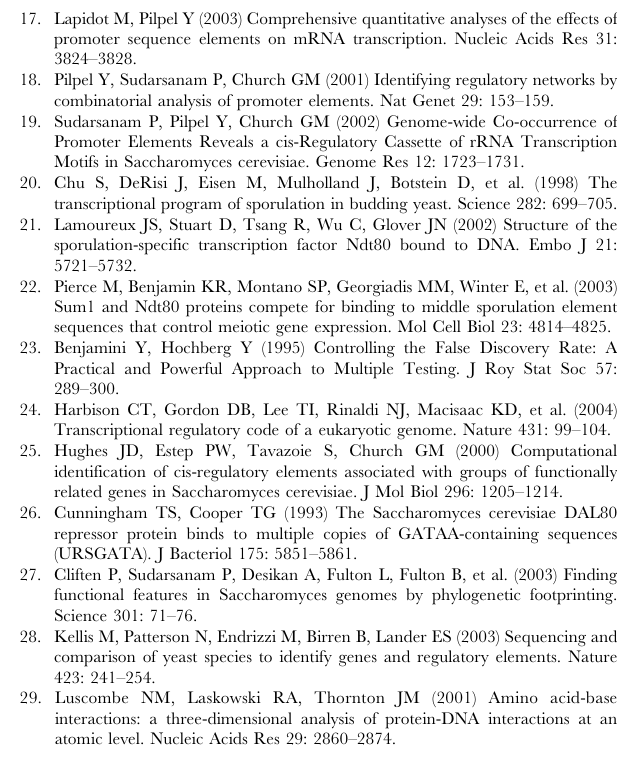
Figure S5 Positional bias of high scoring k-mers. Found at: doi:10.1371/journal.pgen.1000018.s005 (0.15 MB Figure S6 Plot of normalized EC scores versus evolutionary conservation for the highly scoring S. cerevisiae cell cycle k-mers. Found at: doi:10.1371/journal.pgen.1000018.s006 (0.09 MB Figure S7 Distribution of expression similarities for the different types of single nucleotide substitutions Found at: doi:10.1371/journal.pgen.1000018.s007 (0.04 MB Figure S8 Comparison of the age of duplication of pairs of paralogs (approximated by Ks) and their tendency to share known regulatory motifs in their promoters Found at: doi:10.1371/journal.pgen.1000018.s008 (0.12 MB PDF) Figure S9 Distribution of the set sizes of genes examined in constructing the core motif dataset that is relevant for the cell cycle Found at: doi:10.1371/journal.pgen.1000018.s009 (0.03 MB Table S1 Significantly scoring k-mers (our core set motifs). This table lists our core motif sequences, along with their EC scores and p-values in the biological condition in which each motif obtained the most significant score. For motifs that matched at least one of Harbison’s PWMs with a match score higher than 99, the highest scoring match is also listed. Table S2 Redundancy and uniqueness in the core motif dataset